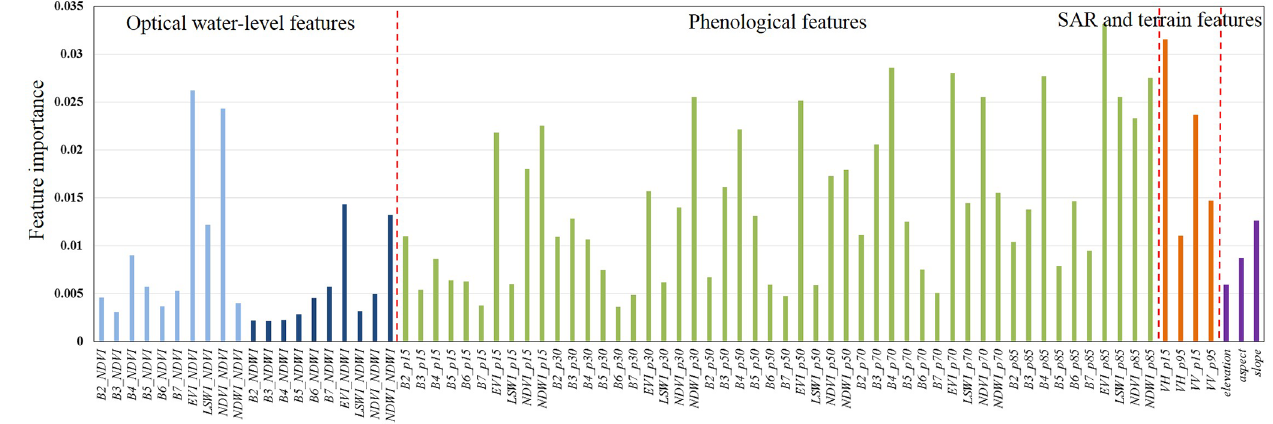
Figure 8. The importance of multi-sourced and multi-temporal features derived from the random forest classification